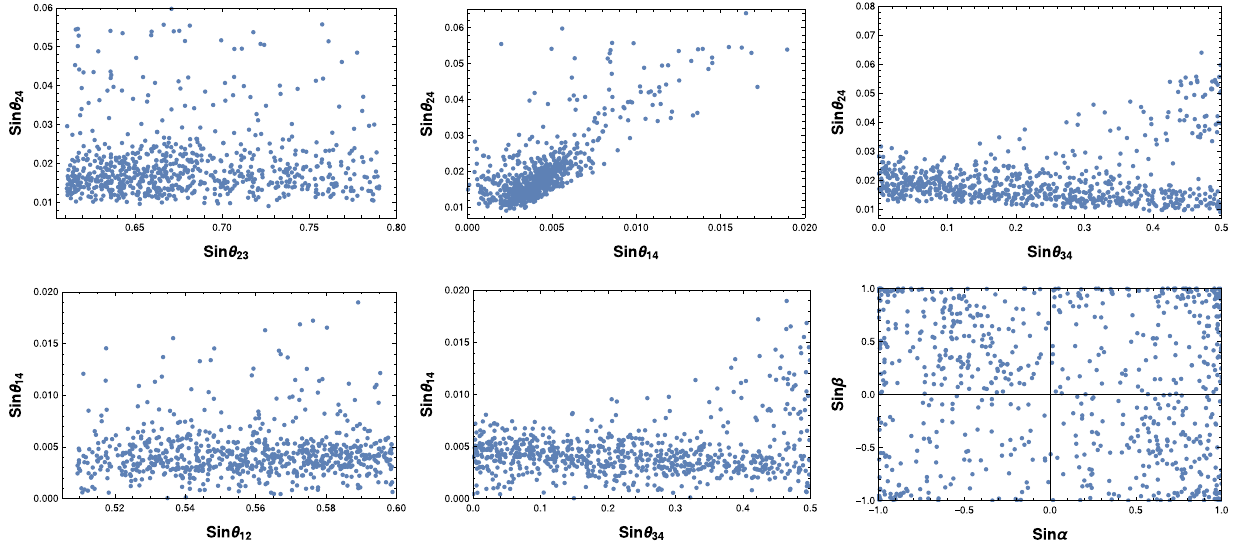
Fig. 7 Neutrino oscillation parameters in active-sterile sector for case (ii) from texture 2 zero category for NH